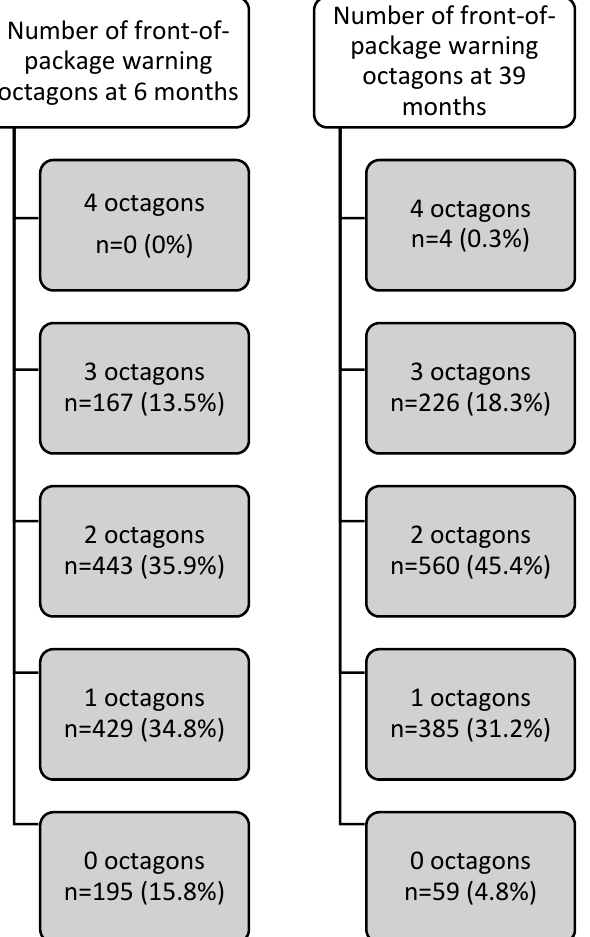
Figure 2. Number of front-of-package warning octagons based on initial at 6 months and final thresholds at 39 months from the implementation of the law.